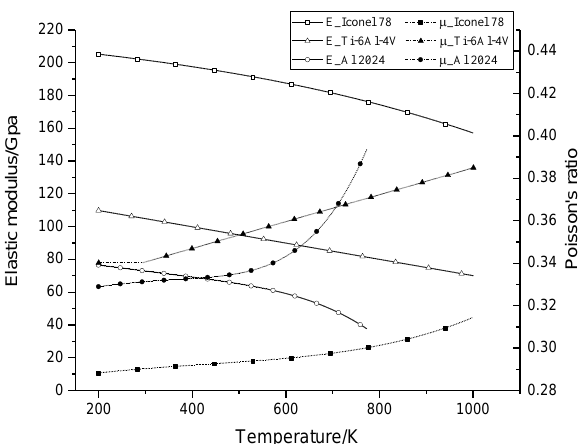
Figure A1. Elastic modulus and Poisson’s ratio of materials varying with temperature.